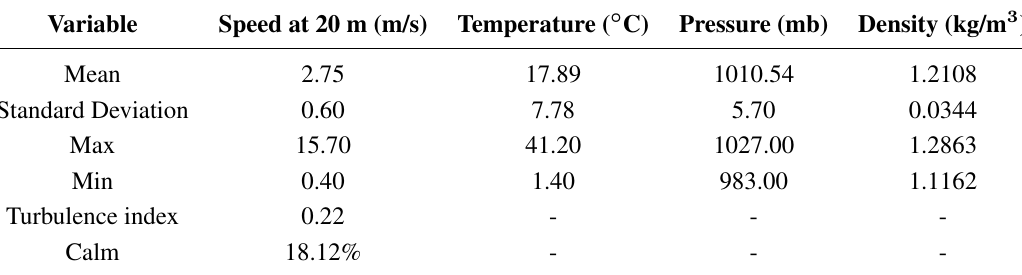
Table 1. Main characteristics of the target station.